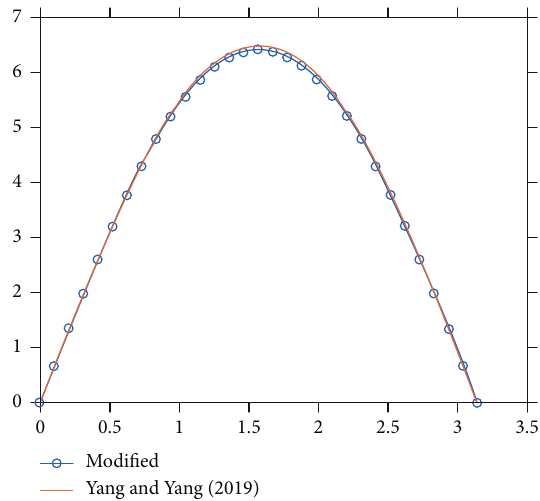
Figure 7: The disparity between the exact solution of the system of equations (2) – (5) and the regularized solution of the system of equations (12) – (15) for p = 1 and k = 1 .